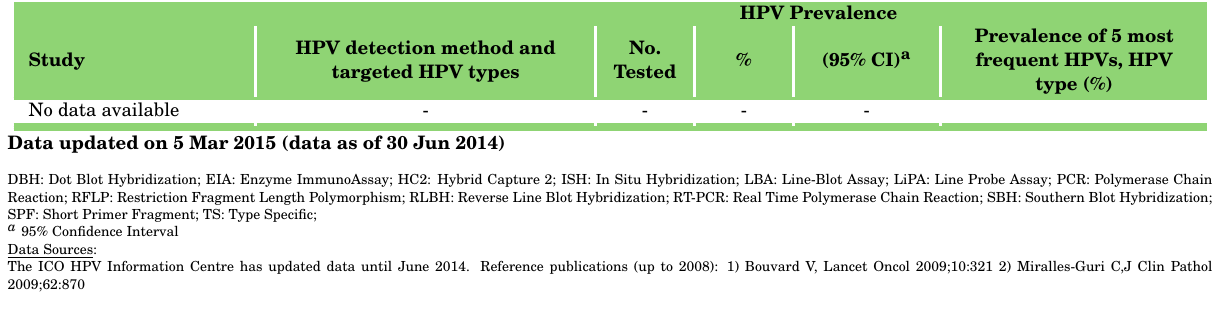
Table 31: Studies on HPV prevalence among penile cancer cases in India